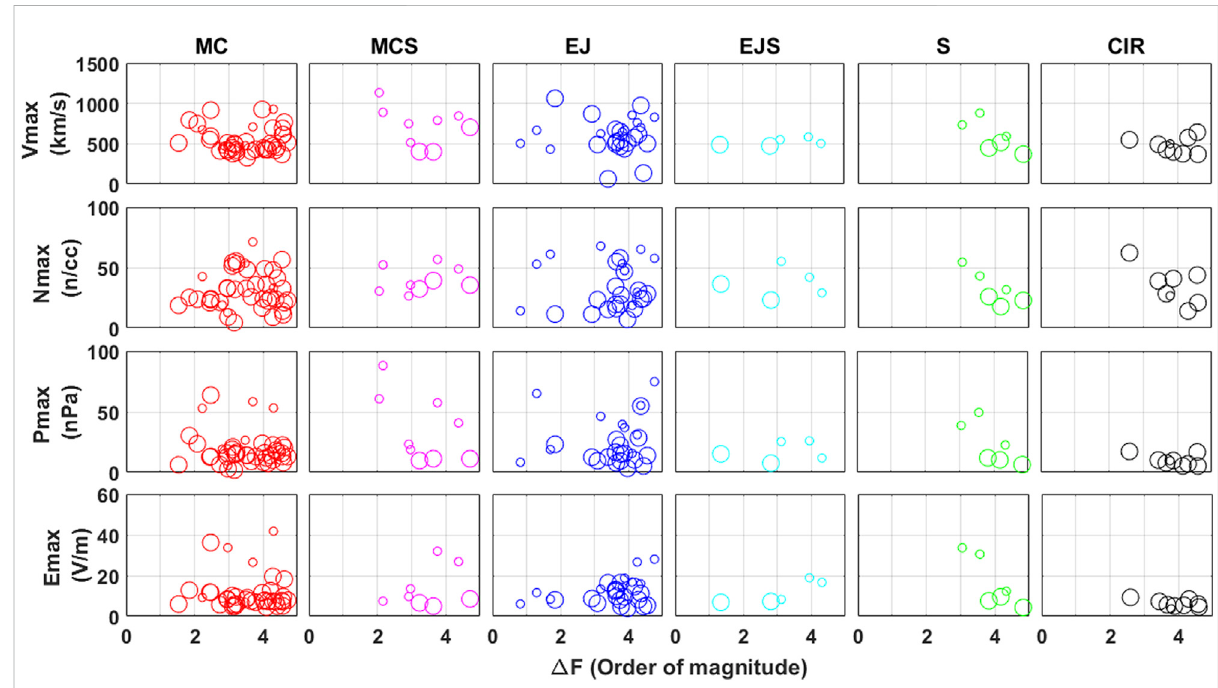
FIGURE 6 Variation of decrease in the electron fl ux ( Δ F in orders of magnitude) with maximum solar wind speed (Vmax in km/s), density (Nmax in n/cc), pressure (Pmax in nPa), and electric fi eld (Emax in V/m) for different solar drivers. Superimposed on that is the R 0 in two groups, R 0 < 6 R E (small circles) and R 0 ≥ 6 R E (big circles).